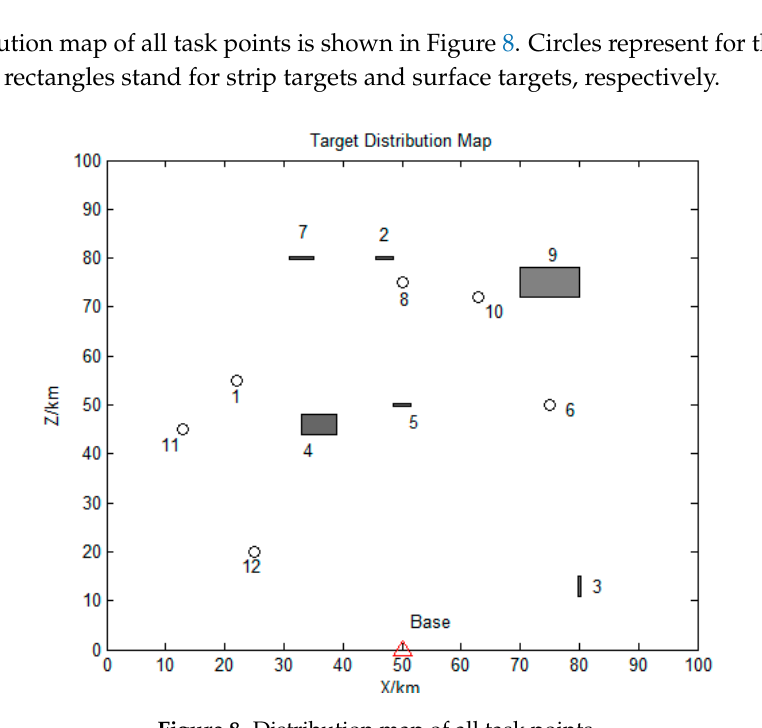
Table 3. Parameters of Task Point Parameters.